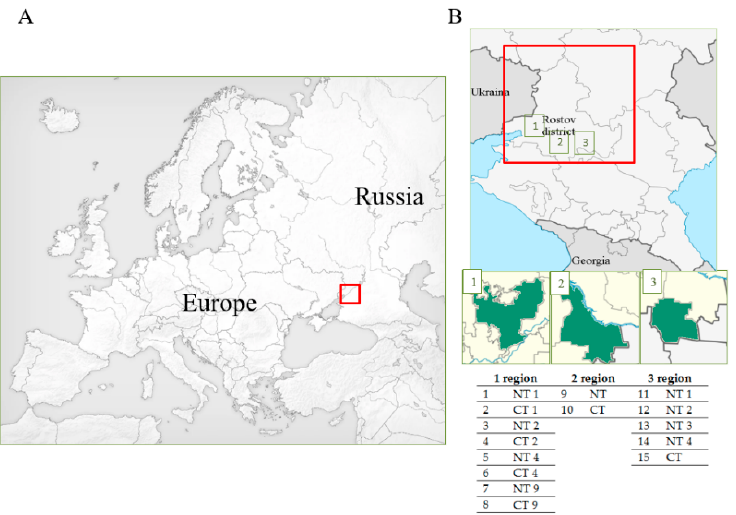
Figure 1. Schematic map of the location of soil sampling sites: ( A ) Map of Europe with the location of sampling sites from 3 regions; ( B ) Location of sampling in Rostov region: Region 1-Haplic Chernozem Calcic; Region 2-Haplic Chernozem Pachic; Region 3-Calcic Chernozem.